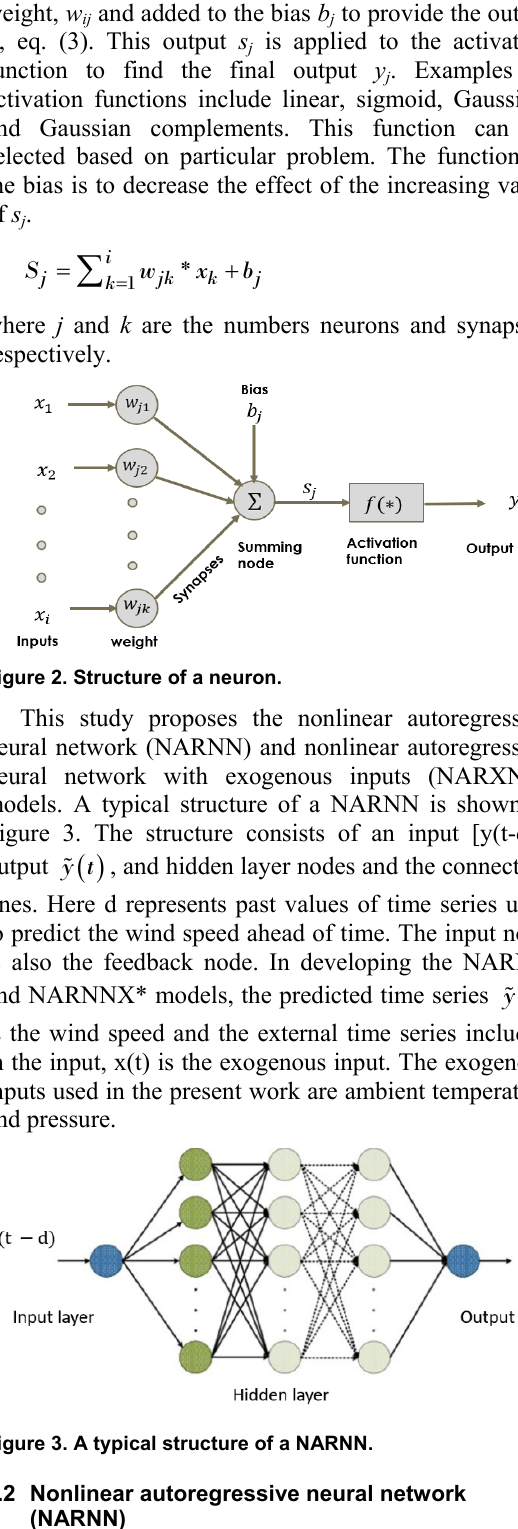
Figure 3. A typical structure of a NARNN. 3.2 Nonlinear autoregressive neural network